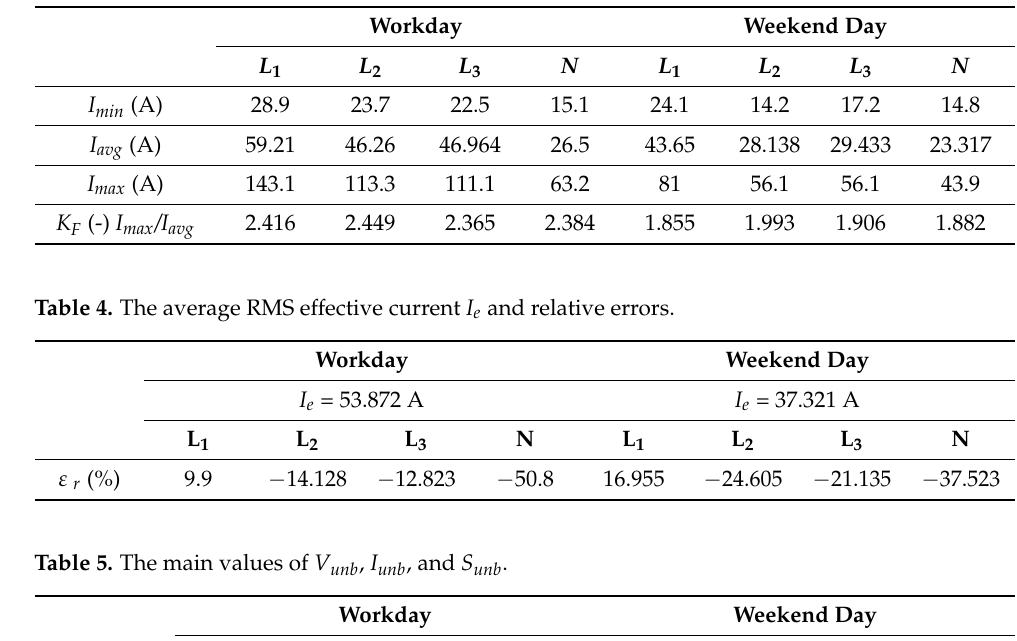
Table 3. The main values of currents.